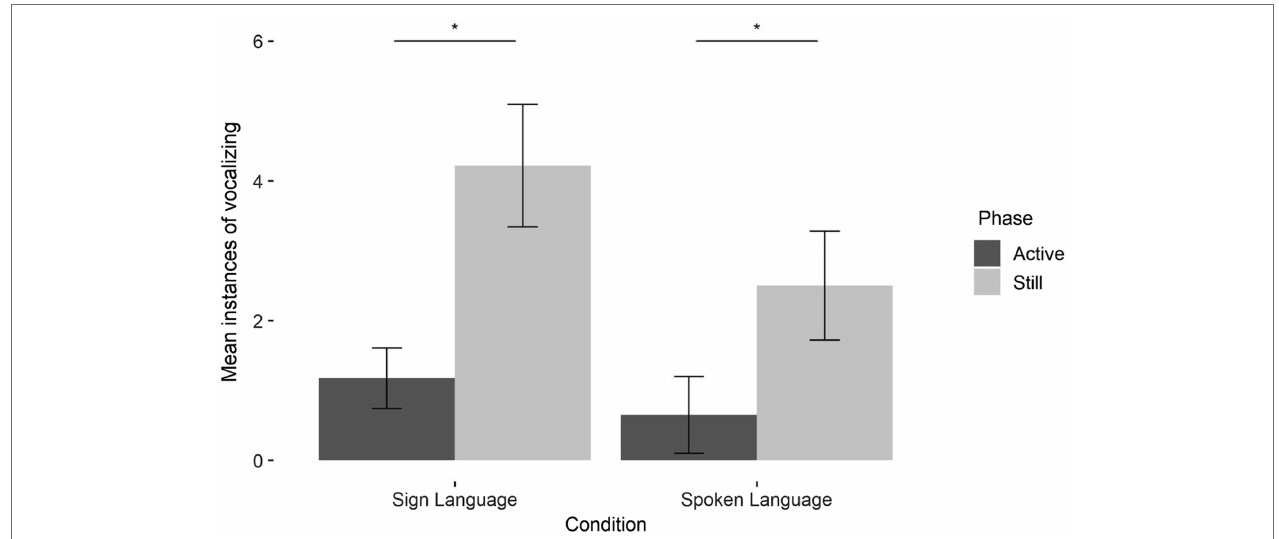
FIGURE 3 | Vocalization production by condition and phase. Within both conditions, more vocalizations occurred during the still phase than the active phase (sign: M active = 1.17, SD active = 2.08, M still = 4.22, SD still = 4.21, t (22) = 3.5, p = 0.002; spoken: M active = 0.7, SD active = 2.45, M still = 2.55, SD still = 3.46, t (19) = 3.1, p =